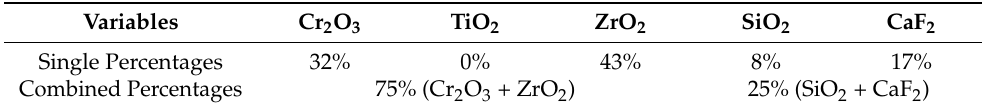
Table 6. The optimal composition of flux.